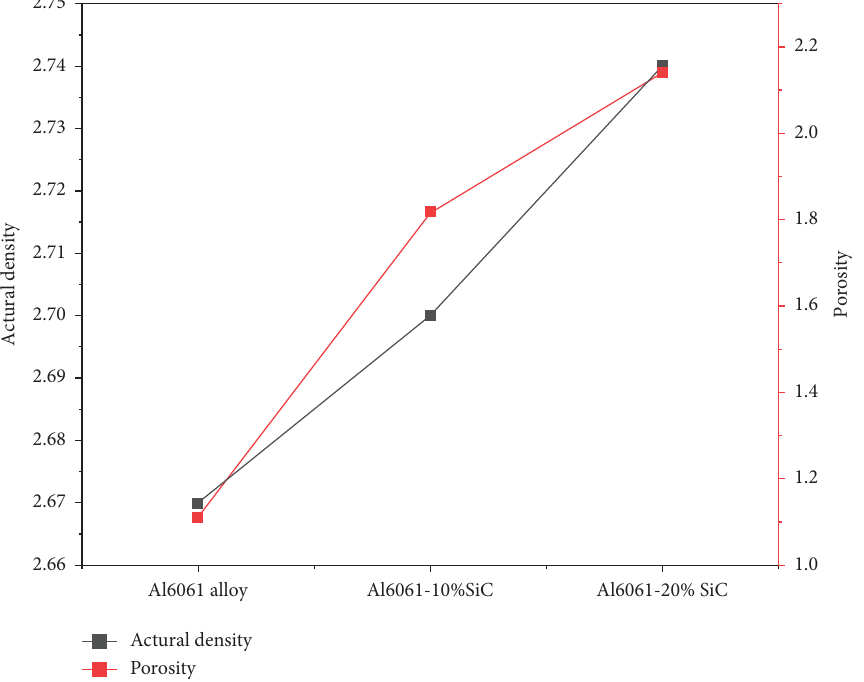
Figure 6: Density of fabricated composite with their corresponding porosity values. Table 2: Acidic immersion corrosion experiment results.